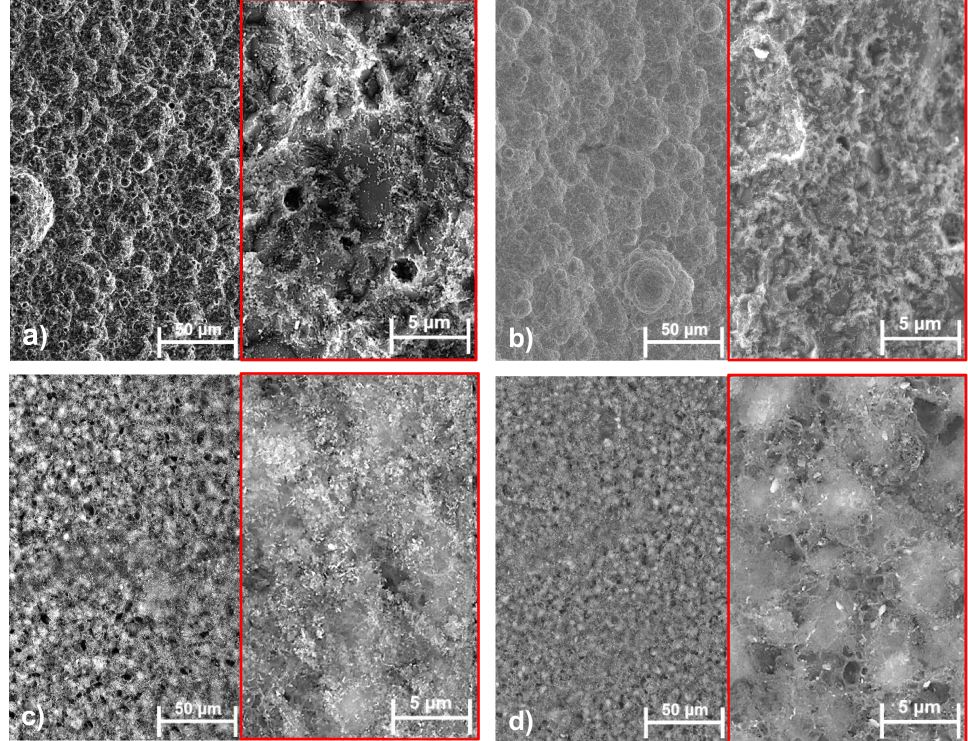
Figure 7. SEM images of the top samples’ morphology after immersion in 0.25 M H 2 SO 4 for 24 h: ( a ) untreated, ( b ) f N2 = 0.1, ( c ) 0.5 and ( d )